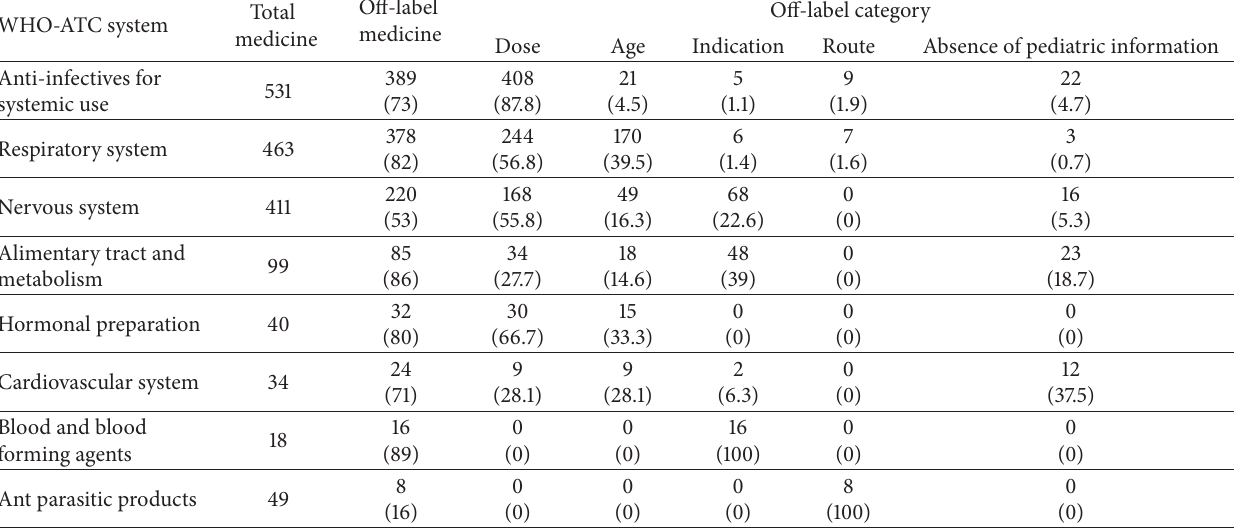
∗ Note: the total number of off-label uses may exceed that of off-label drugs because a drug may be off-label for more than one category. Figures in parentheses indicate